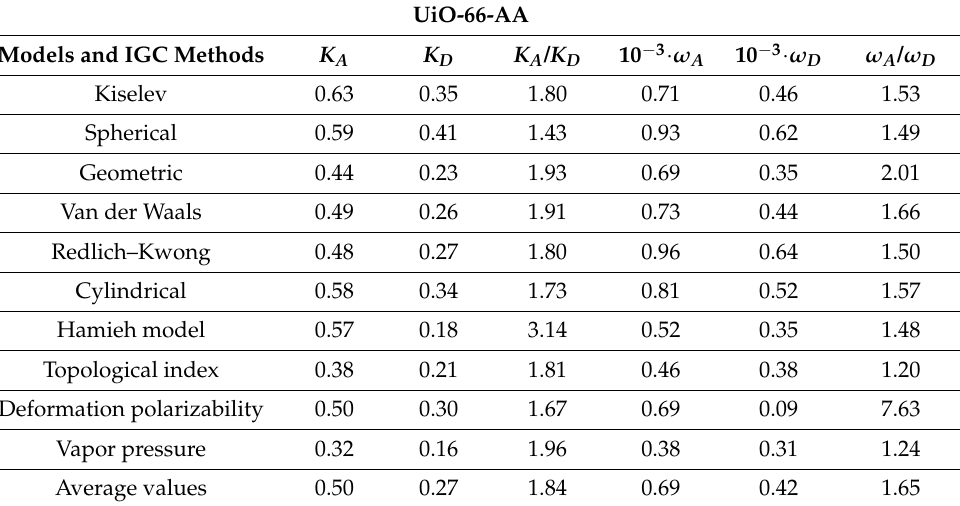
Table 7. Values of the enthalpic acid–base constants K A and K D (unitless) and the entropic acid–base constants ω A and ω D (unitless) of UiO-66-AA catalyst and their acid–base ratios for the different used molecular models and IGC